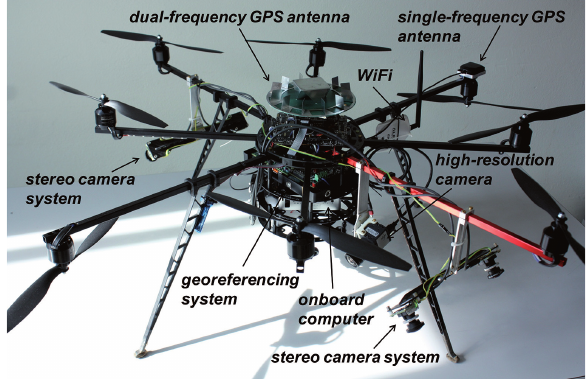
Figure 5: Our 5kg UAV platform equipped with several sensors and connected with our mission planing